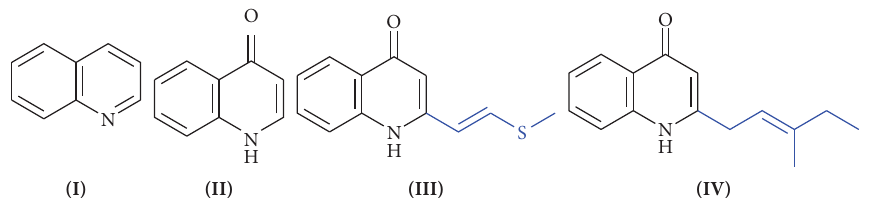
Figure 1: Structures of quinoline ( I ), quinolin-4(1 H )-one ( II ), and the two natural derivatives ( E )-2-[2-(methylthio)vinyl]quinolin-4(1 H )-one ( III ) and ( E ) - 2-(3-methylpent-2-en-1-yl)quinolin-4(1 H )-one ( IV